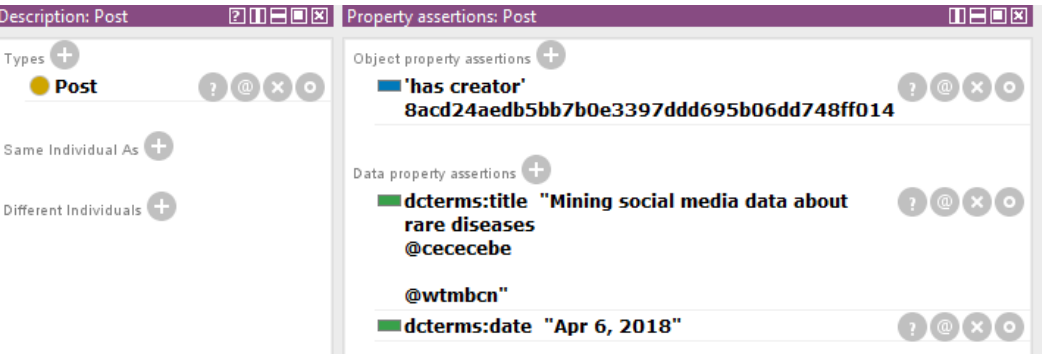
Figure 3. Anonymous representation of a patient in the proposed ontology. A SHA1 operation has been performed on the names of the people in order to preserve their anonymity.